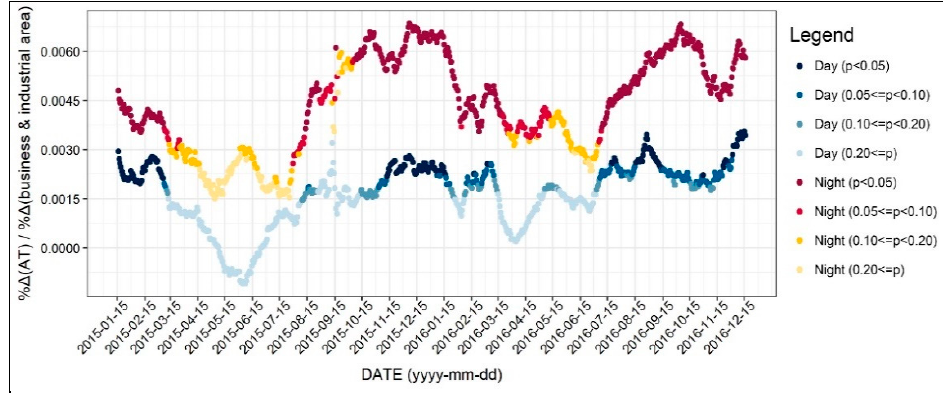
Figure 11. Changing patterns in the regression coefficients and their significances (business and industrial use).